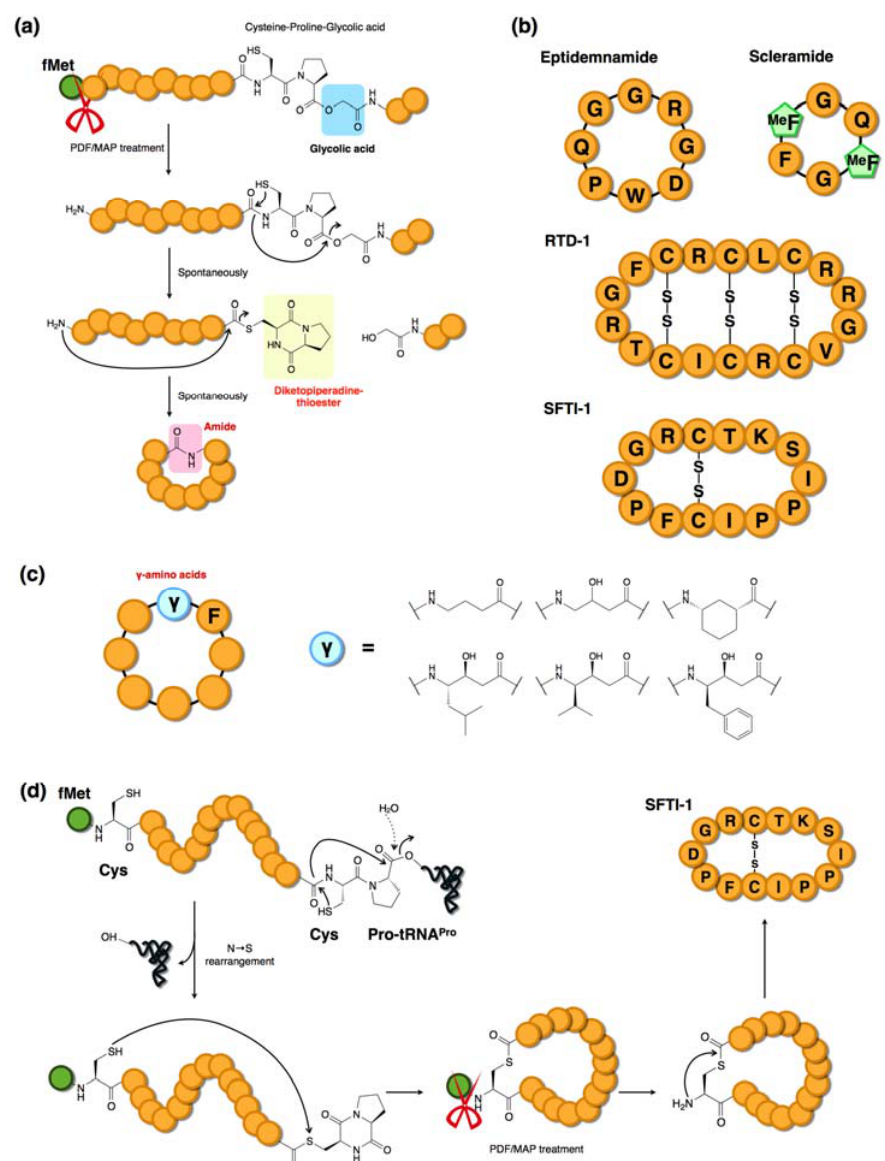
Figure 6. Mainchain macrocyclizations via diketopiperadine (dkp)